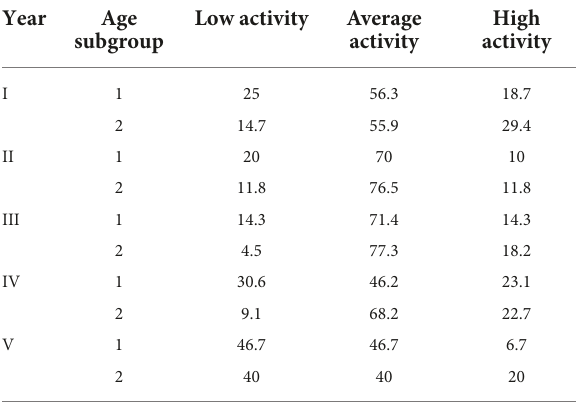
TABLE 5 Frequency of occurrence of different levels of activity in psychology students after classes (in